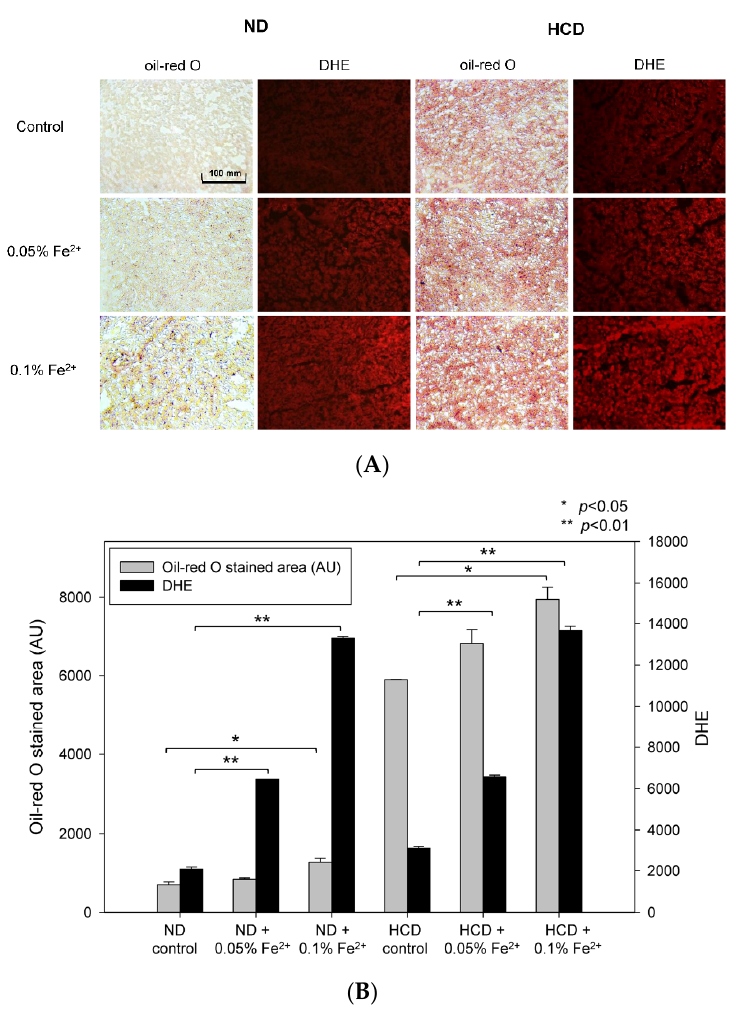
Figure 7. Histological analysis of hepatic tissue. ( A ) Representative sections for histological assessment of hepatic microsections after consumption of ferrous ion (0.05% and 0.1% wt/wt in diet) for 24 weeks under normal diet (ND) or high cholesterol diet (HCD). Extent of fatty liver changes was compared by oil red O staining. Production of reactive oxygen species was determined by Dihydroethidium (DHE) staining and visualized by fluorescence (Ex = 588 nm, Em = 615 nm); ( B ) Quantification of oil red O stained area and DHE stained area by computer ‐ assisted morphometry using Image Proplus software (version 4.5.1.22; Media Cybernetics, Rockville, MD, USA). *, p < 0.05; **, p < 0.01.